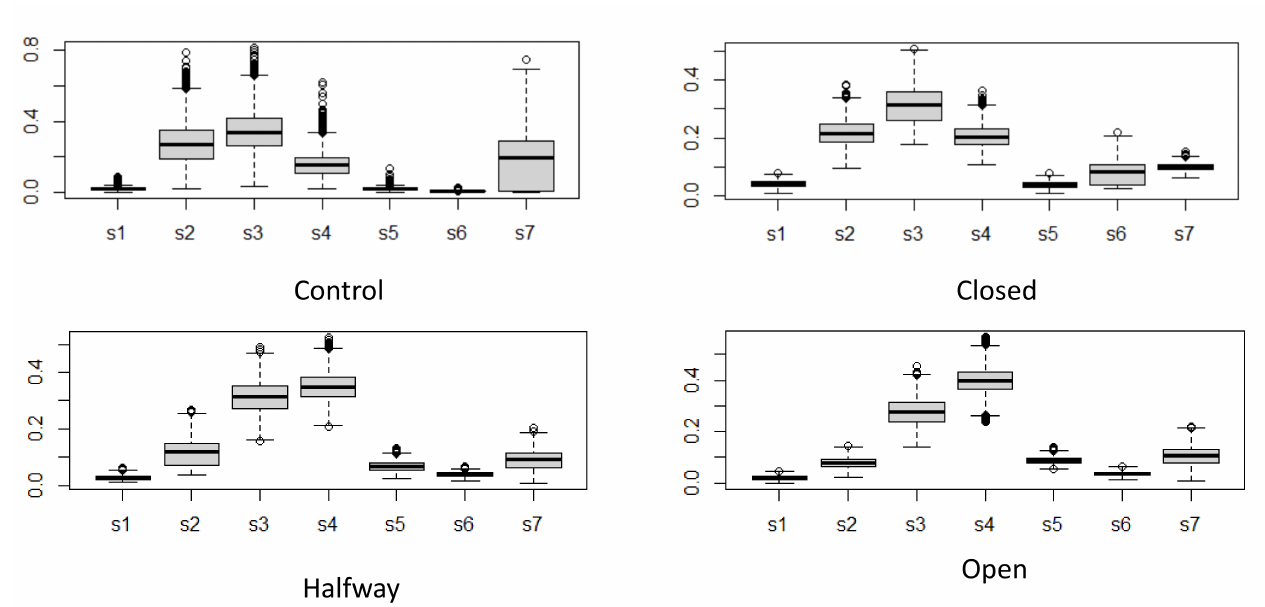
Figure 11. Box plot of proportion of sediment weights for different grain sizes.